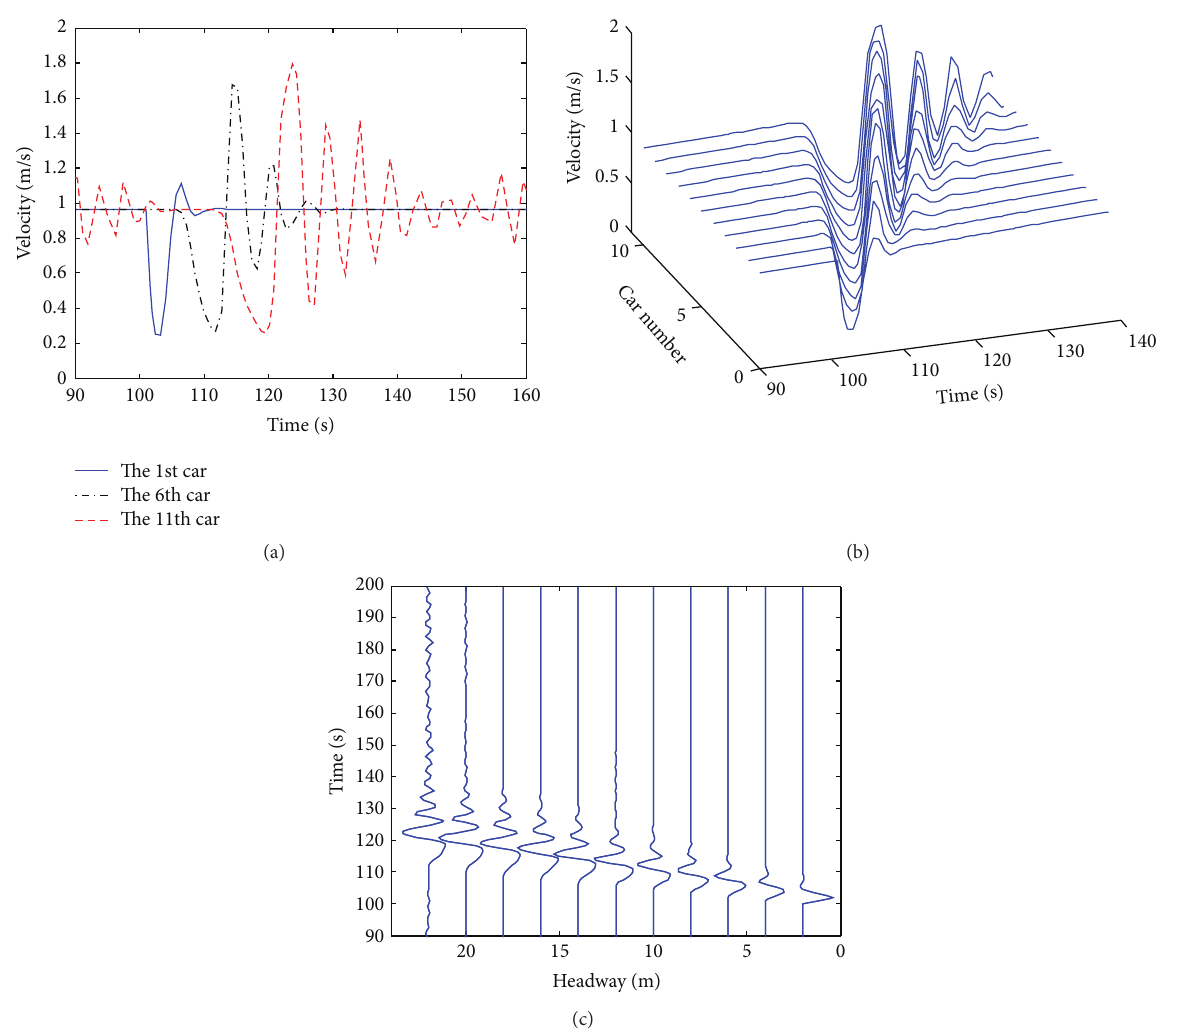
Figure 3: Car-following model without the controller: (a) speed-time image of vehicles 1, 6, and 11, (b) speed-time image of all vehicles, and (c) headway-time